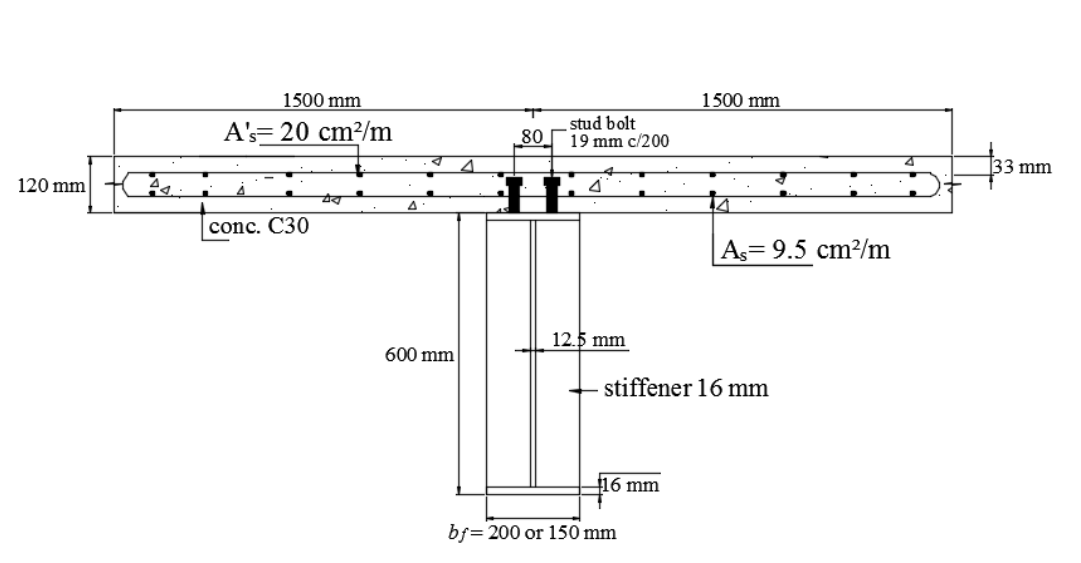
Figure 10. Cross section of the reference numerical model in the internal supports’